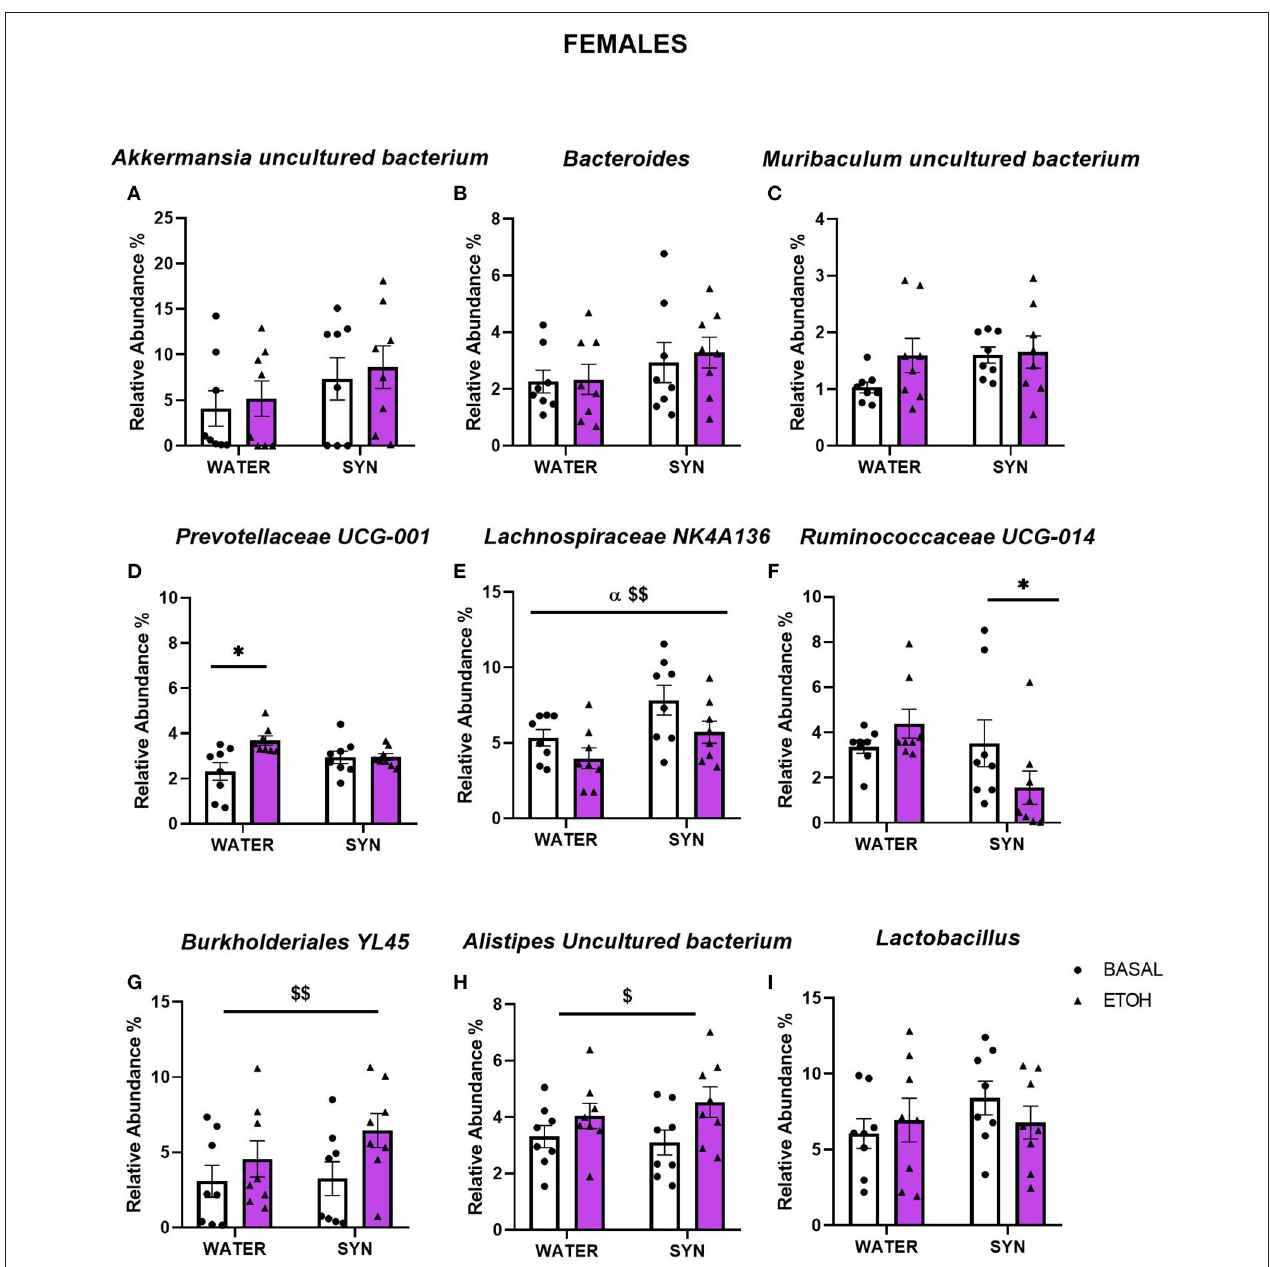
FIGURE 7 | Changes in gut microbial species relative abundance in female mice treated with water or synbiotic (SYN) following 2 weeks of baseline (BASAL; no alcohol; white bars, round symbols), and after 20 days of intermittent access to alcohol (ETOH, violet bars, triangular symbols). No significant changes were observed in Akkermansia uncultured bacterium (A) , Bacteroides (B) , or Muribaculum uncultured bacterium (C) . Prevotellaceae UCG-001 abundance was significantly increased by alcohol intake only in the group exposed to water ( p < 0.05) (D) . For Lachnospiraceae NK4A136, synbiotic exposure increased abundance under basal conditions, and alcohol decreased relative abundance in both the water and the synbiotic groups (E) . Ruminococcaceae UCG-014 was significantly decreased only in the synbiotic group ( p < 0.05) (F) . Alcohol significantly increased Burkholderiales bacterium YL45 (G) , and Alistipes uncultured bacterium (H) abundance in both the water and synbiotic groups ( p < 0.01 and p < 0.05), respectively. Finally, Lactobacillus abundance (I) was not significantly modified by alcohol or synbiotic treatment. $ p < 0.05; $$ p < 0.01 (main effect of alcohol). α p < 0.05 (main effect of treatment). * p < 0.05 (LSD post-hoc test following significant interaction in two-way